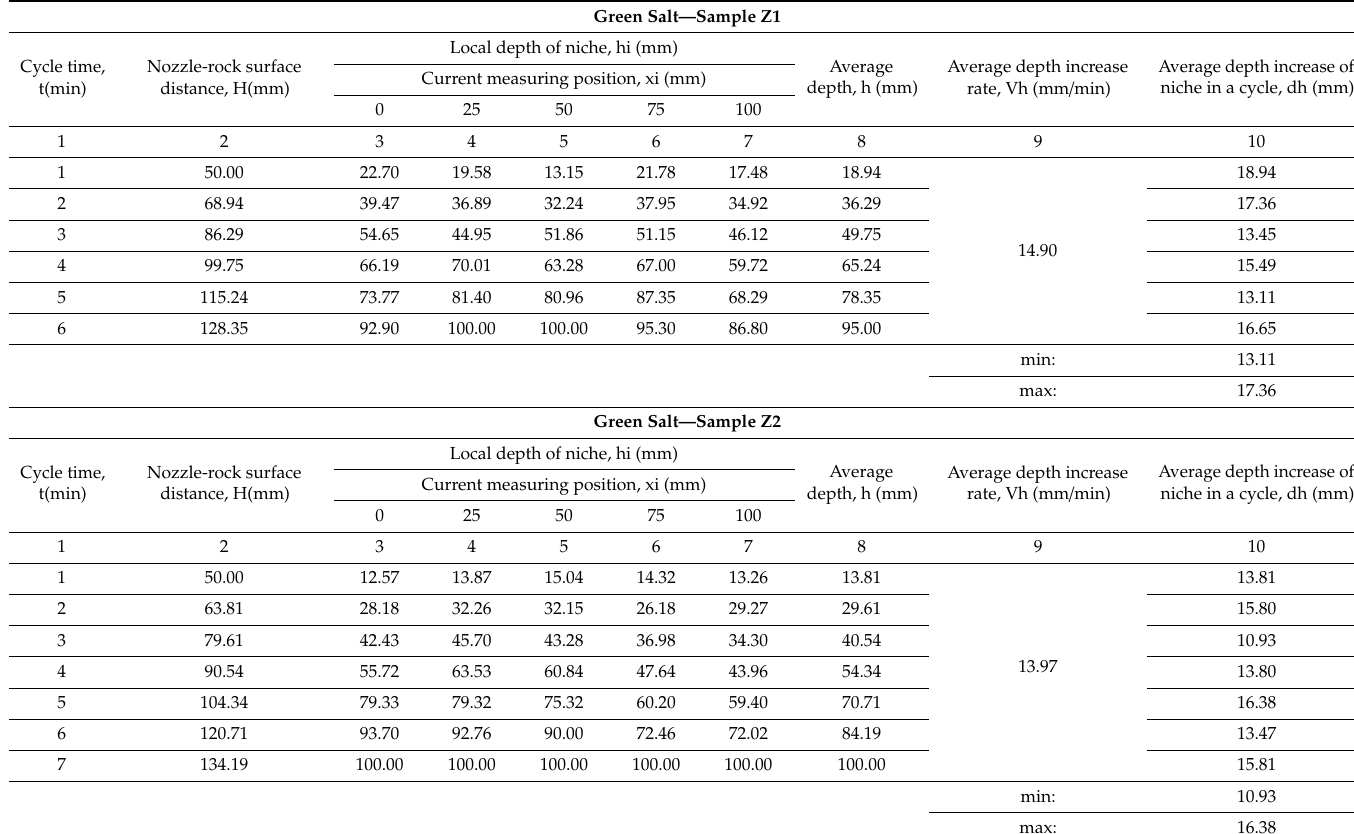
Table 3. Results of measurements of high-pressure water jet niche cutting parameters—“green salt”